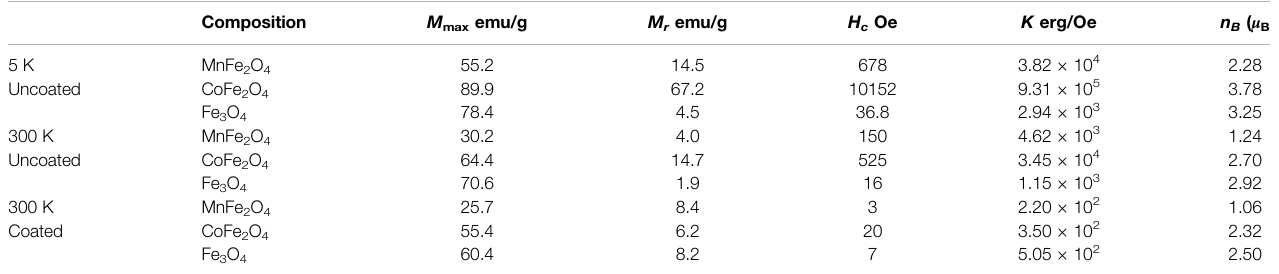
TABLE2| Maximummagnetization( M max ),remnantmagnetization( M r ),coercivity( H c ),averageanisotropy( K ),andmagneticmoment( n B )ofMnFe 2 O 4 ,CoFe 2 O 4 ,andFe 3 O 4 spinel ferrites nanoparticles in the uncoated condition at 5 and 300 K, and in the coated condition at 300 K.